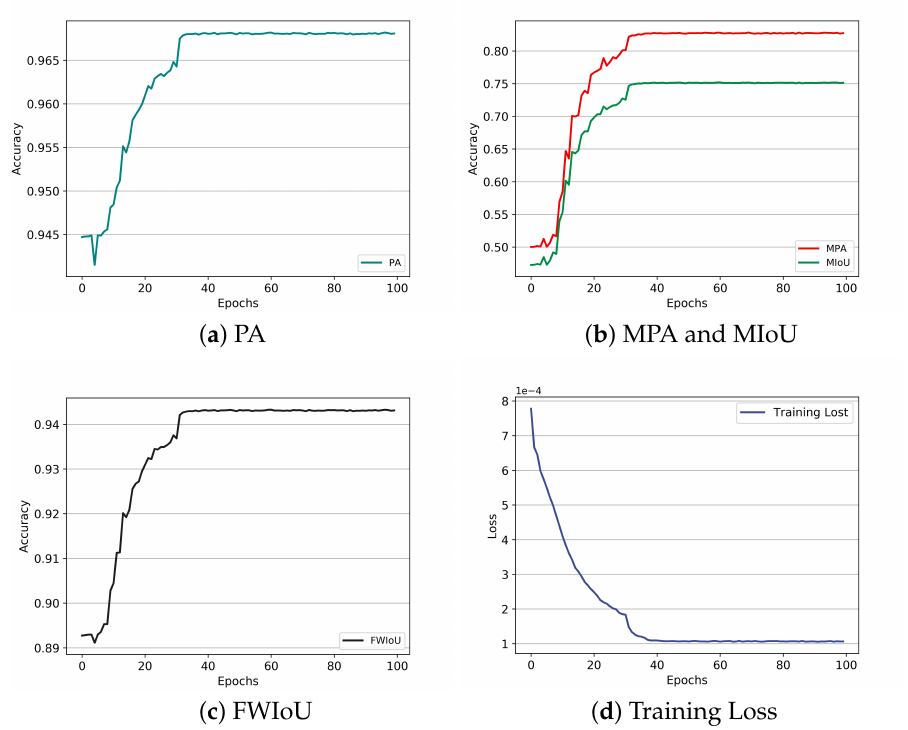
Figure 9. Semantic segmentation results on the validation set and training set of DEM data, ( a – c ) show the results of the validation set and c denotes the results of the training set. ( a ) is PA, ( b ) represents the MAP and MIoU, ( c ) denotes the FWIoU, and ( d ) is the training loss of the training